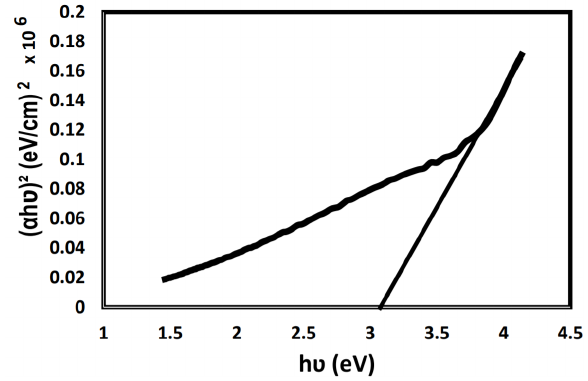
Figure 5: Direct band gap of 𝛾 -Fe 2 O 3 -Ag 2 O nanocomposite.